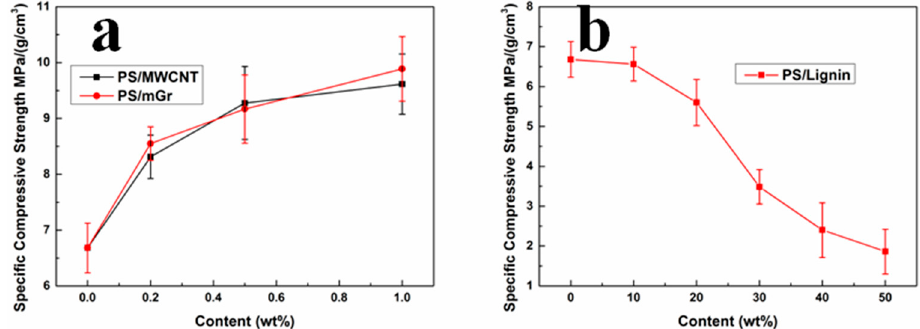
Figure 6. Specific compressive strength of different PS composite foams: ( a ) PS/MWCNT and PS/mGr; ( b ) PS/lignin.